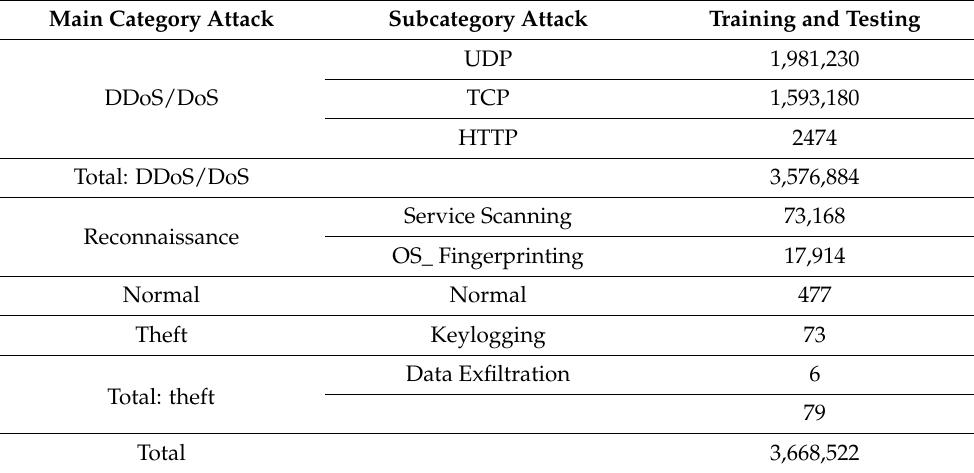
Figure 8. Services Distribution.